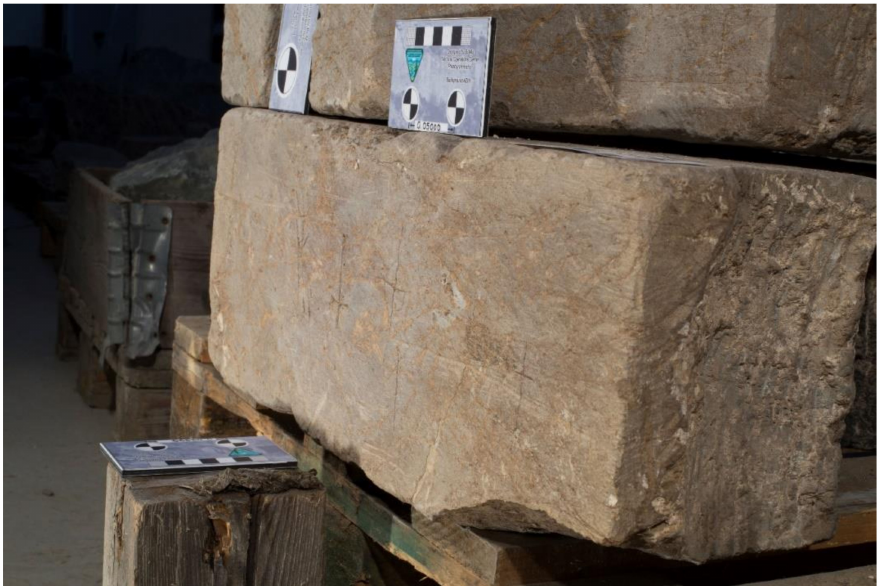
Figure 1. Surface A, located on a 13th century building stone currently in a storage facility.